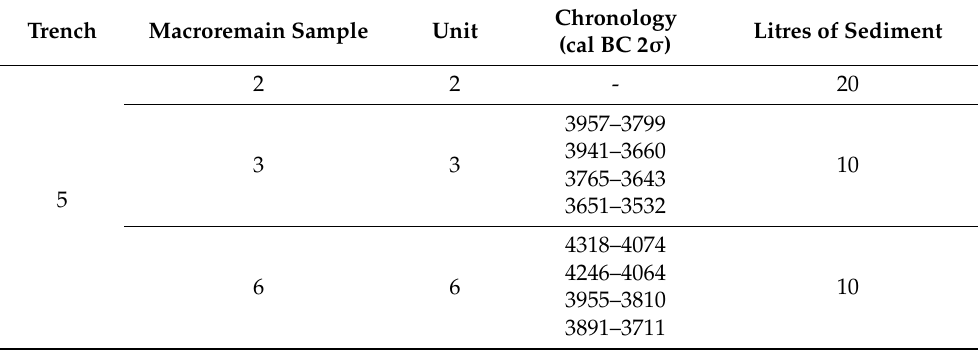
Table 2. Colombare di Negrar: List of macroremain samples from Trench 5.